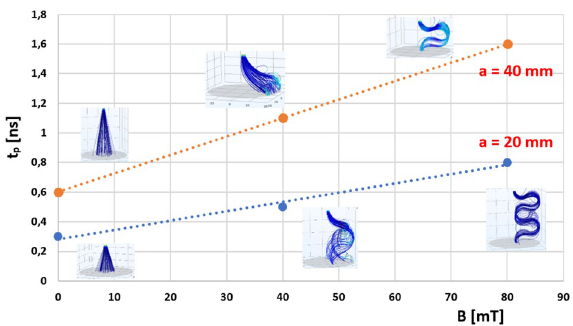
Figure 4. Electron beam propagation time t p as function of background magnetic field B in point-plane configuration, a —interelectrode distance.